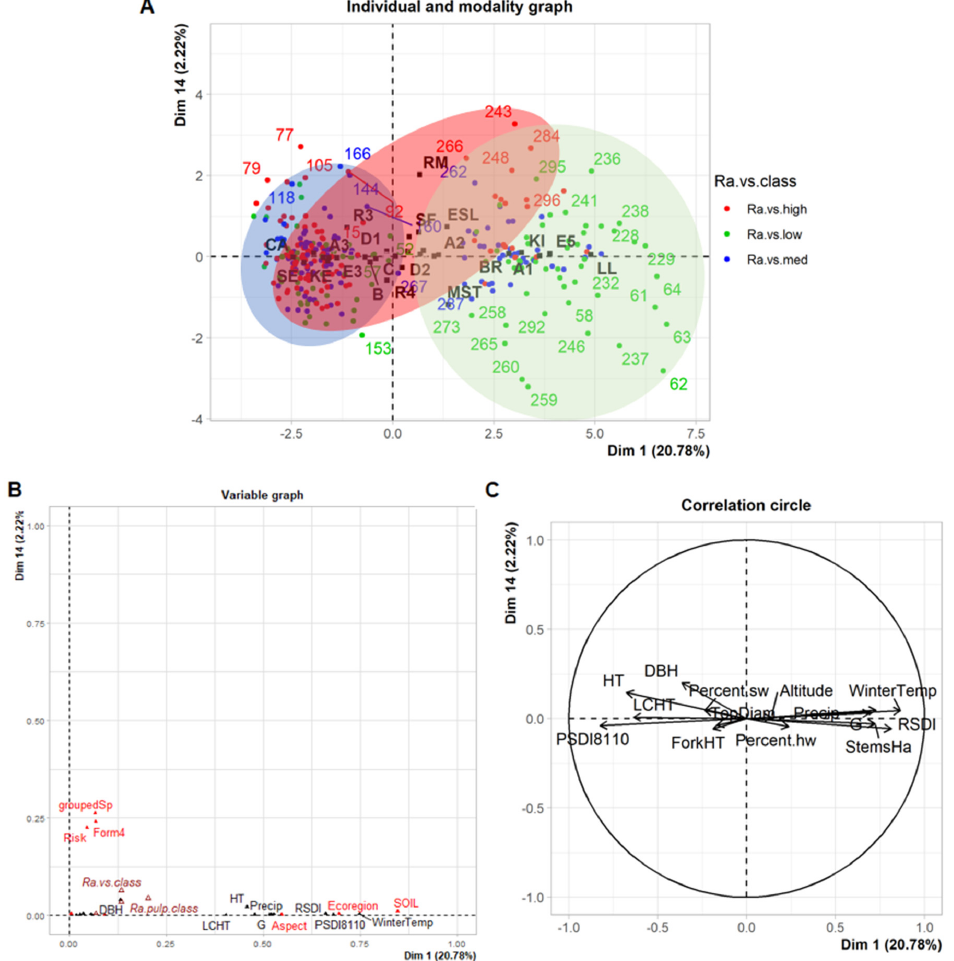
Figure 13. Individuals and modality graph ( A ), variable graph ( B ), and correlation circle ( C ) of FAMD on 302 trees bearing products and having environmental data. In graphic A, coloration depending on the (sawlogs + veneer)/total volume ratio.